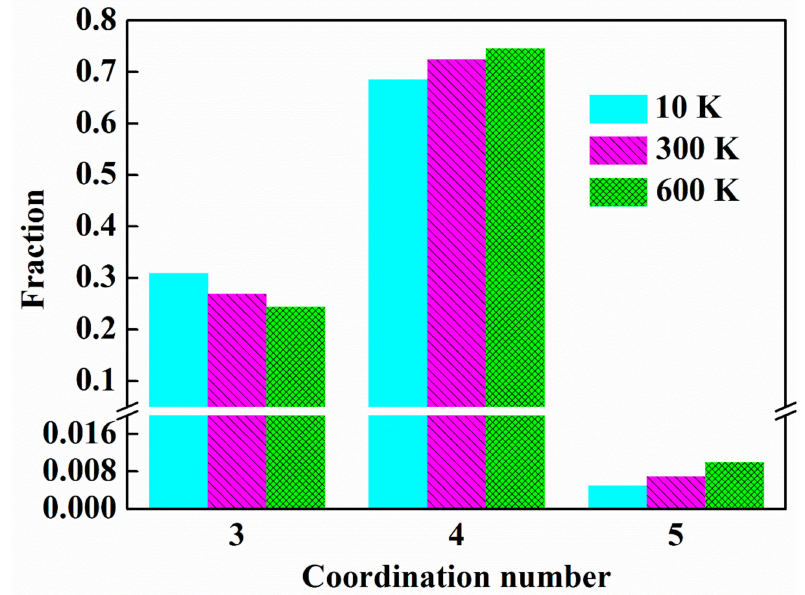
Figure 8. Radial distribution functions (RDFs) for ng-AlN d = 1 nm at di ff erent temperatures—10 K, 300 K, 600